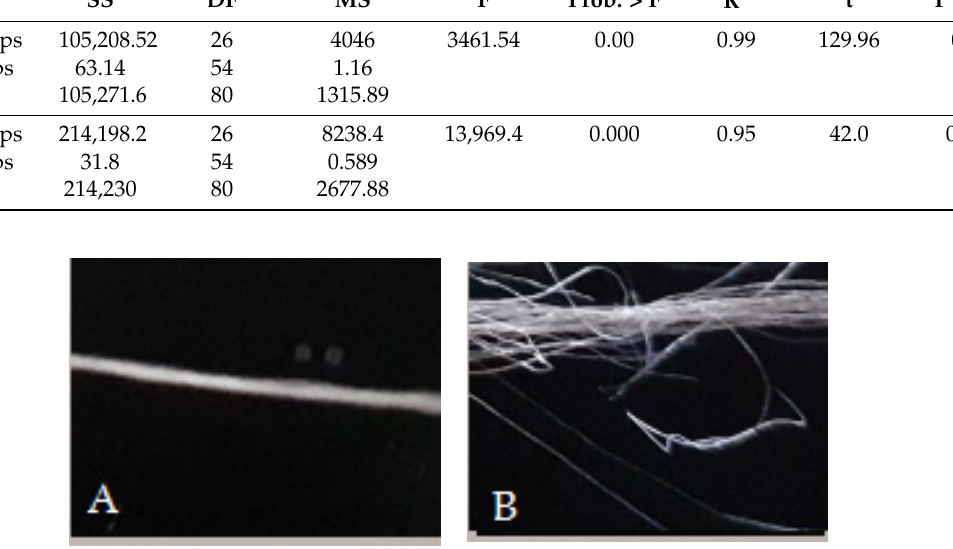
Figure 11. SCV conductive yarn before ( A ) and after ( B ) abrasion.